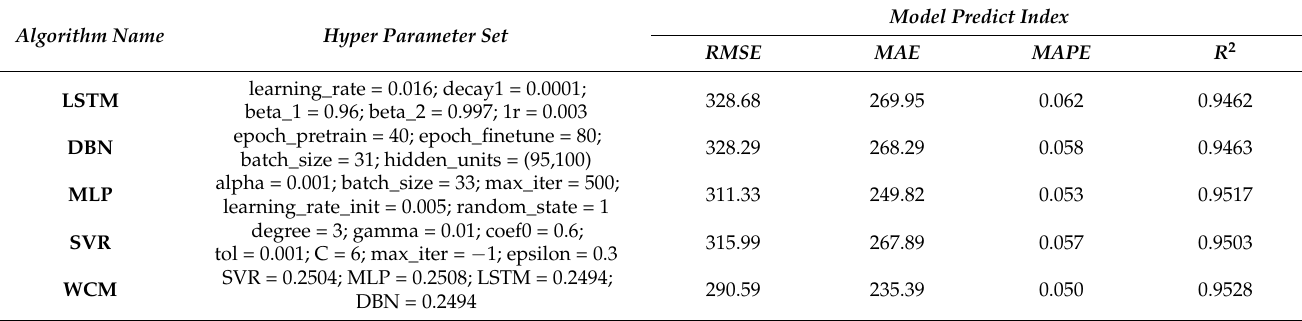
Table 3. Super parameters and evaluation indexes of each